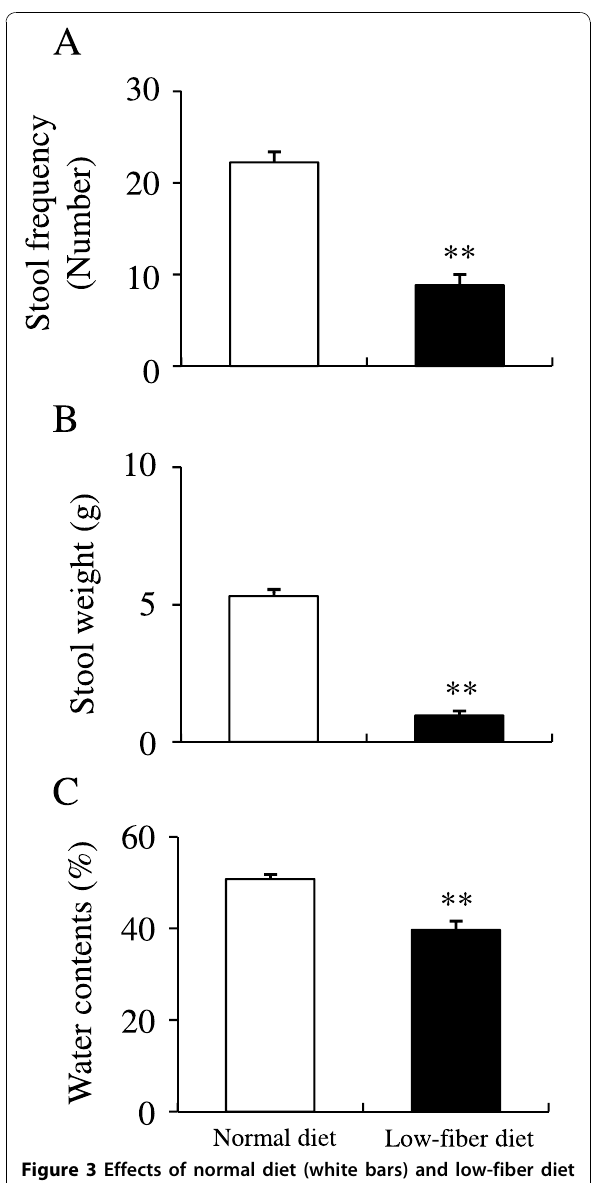
Figure 3 Effects of normal diet (white bars) and low-fiber diet (black bars) on frequency (A) weight (B) and water content (C) of stools over a 16 h period in rats . Data are shown as the mean ± S.E.M., n = 12, *p < 0.05, **p < 0.01 vs. vehicle (one-way ANOVA and Tukey ’ s multiple comparison test).